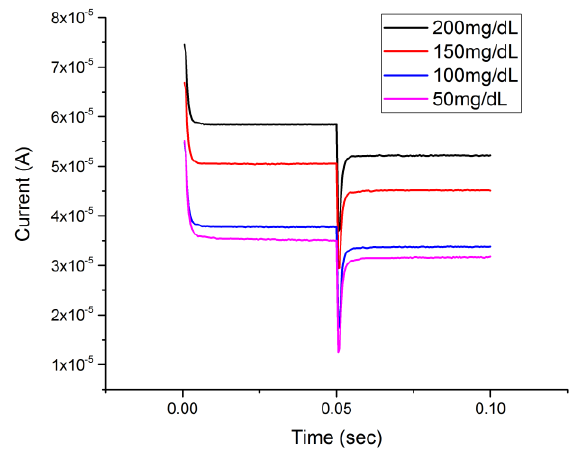
Figure 5. Chronoamperometry measurement of glucose concentrations ranging from 200 mg/dL to 50 mg/dL.